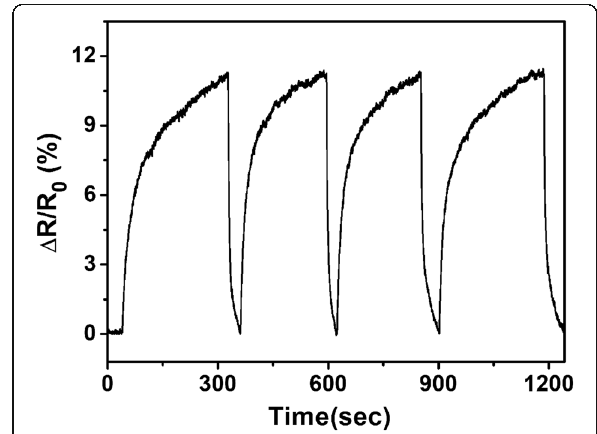
Fig. 7 Repeatability of response of rHGO thin-film sensor to 50 ppm NH 3